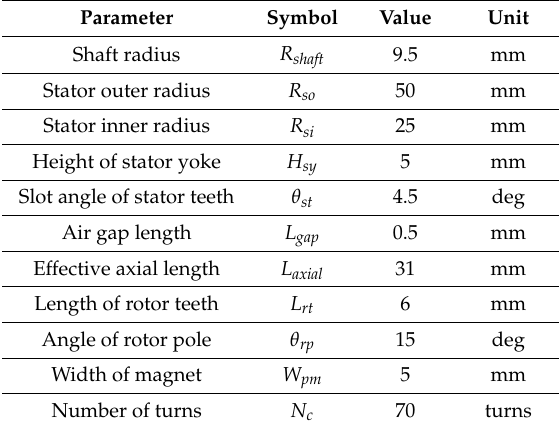
Figure 1. Structure of an FSPMM with SMC cores, ( a ) one-phase structure, ( b ) winding and magnets, ( c ) stator part, and ( d ) rotor part. Table 1. Main dimensions of the FSPMM with SMC